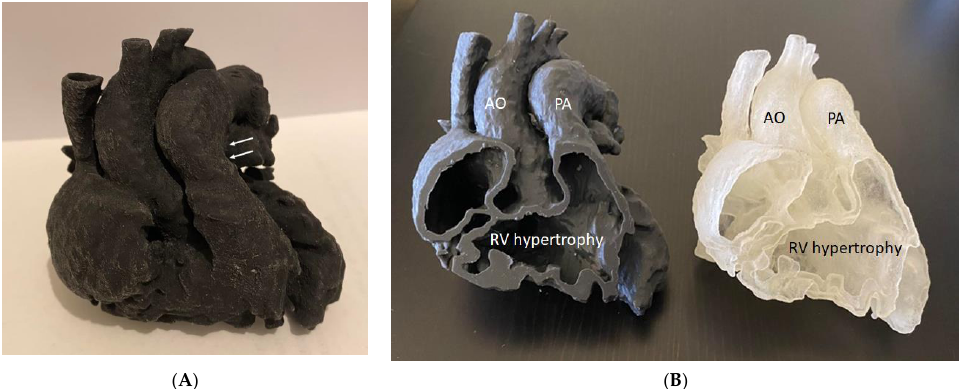
Figure 2. Three-dimensional-printed heart model of a case with Tetralogy of Fallot (ToF). ( A ): The model was printed in one piece. ( B ): The model was printed in two halves (with the same material, Agilus30, but different colors) showing the internal cardiac chambers and vascular abnormalities. Arrows indicate the pulmonary artery stenosis. AO—aorta (overriding aorta); PA—pulmonary artery; RV—right ventricle.